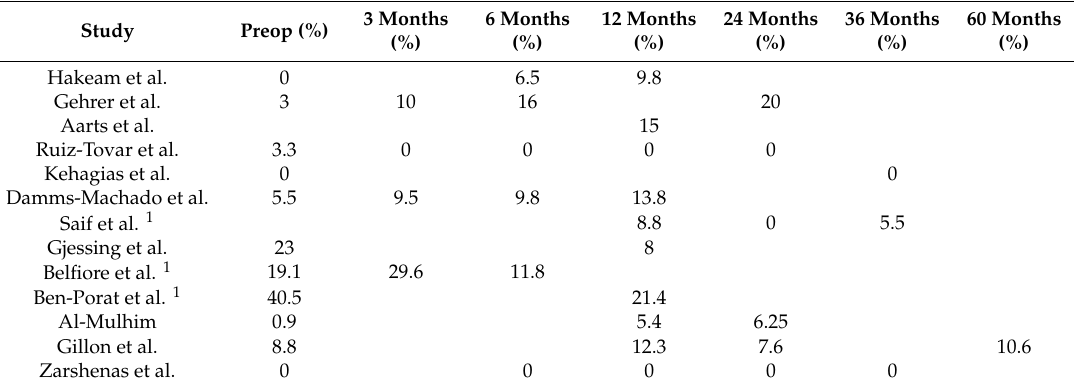
Table 5. Folate: Percentage (%) of patients with deficiencies at each postoperative